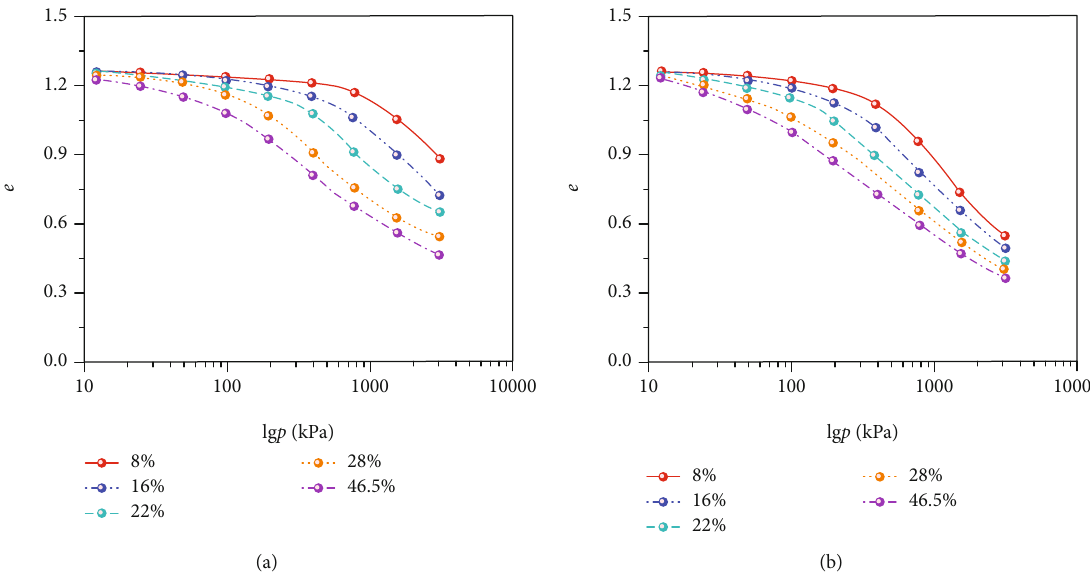
Figure 3: Compression lines at di ff erent moisture contents for (a) undisturbed loess and (b) remoulded